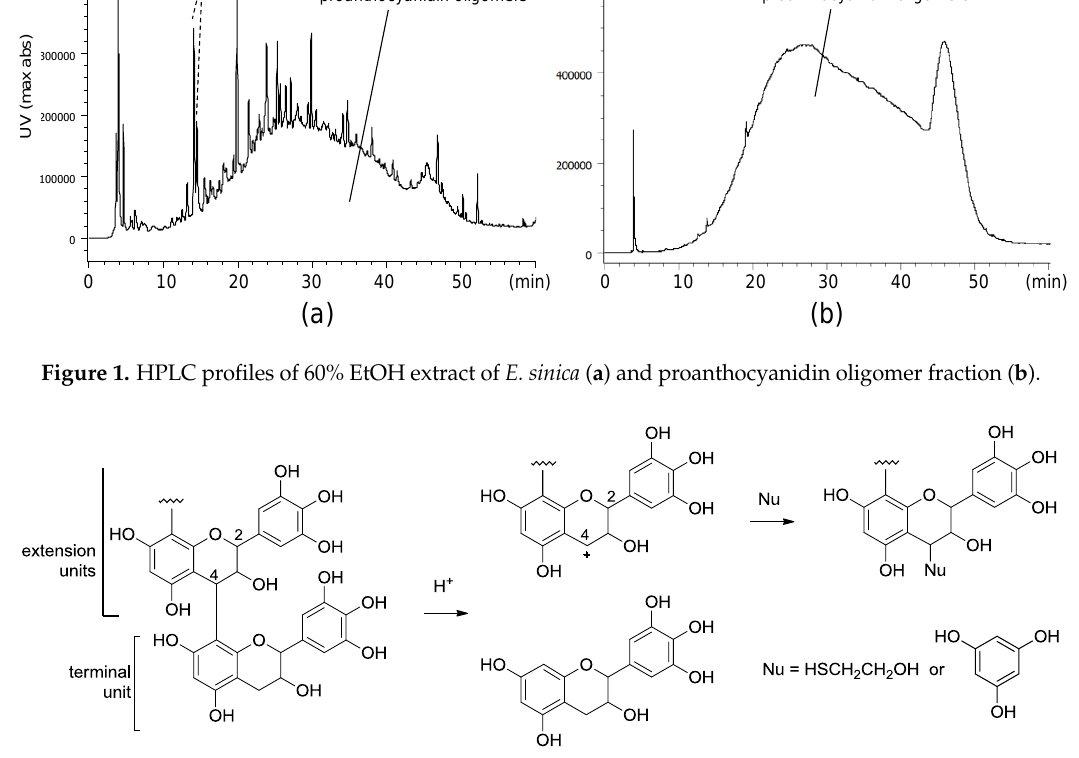
Scheme 1. Reaction mechanism of the acid-catalyzed cleavage of the interflavan bond in the presence of nucleophiles (Nu).